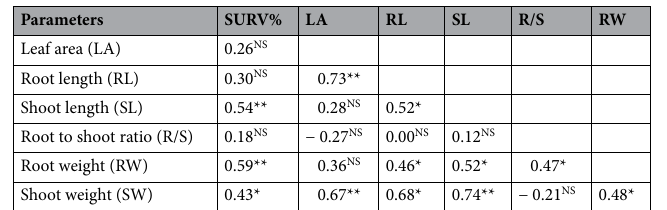
Table 3. Pearson correlation among the morphological parameters of the sunflowers under heat stress. *Significant to P ≤ 0.05. **Significant to P ≤ 0.01.